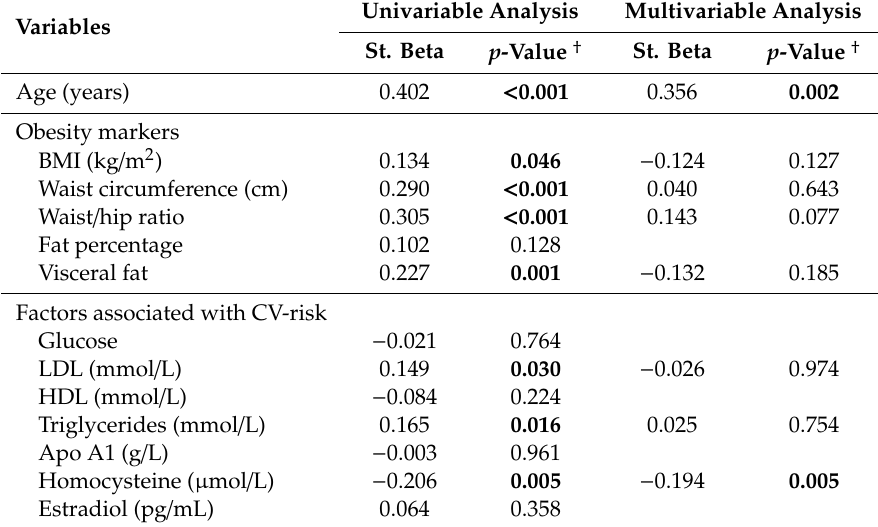
Identification of independently associated variables with serum free thiol levels in reproductive